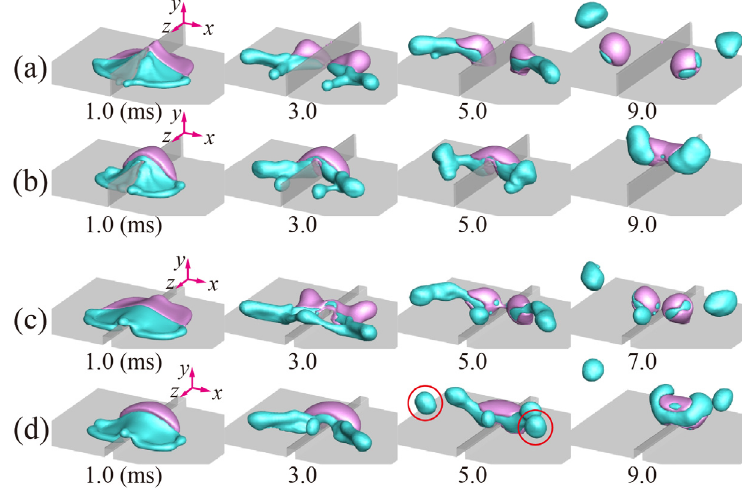
Figure 7. Dependency of Ω on ( a ) height and ( b ) width of the ridge. Filled and open symbols repre- sent the fragmentation/non-fragmentation situations for G-part, respectively. Snapshots of the in- sets are obtained from drop impact on macroridges with ( a ) h / D 0 = 0.1, 0.35, and 0.5 and ( b ) w / D 0 = 0.05, 0.2, and 0.4 for two viscosity ratios of α 1 and α 3 . The Weber number in ( a , b ) corresponds to We w = 61.